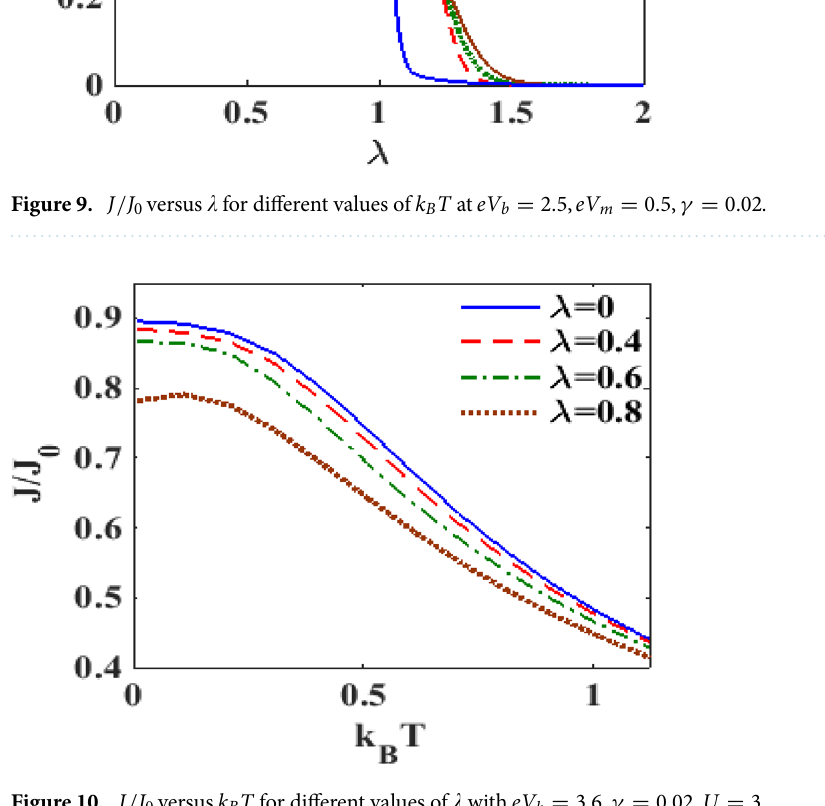
Figure 10. J / J 0 versus k B T for different values of (cid:31) with eV b = 3.6, γ = 0.02, U =